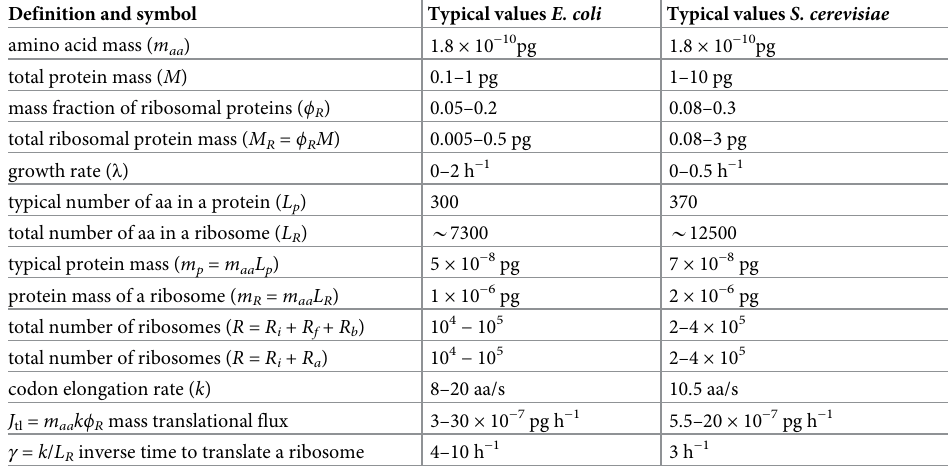
Table 1. Summary of the symbols used in the text. E. coli data are taken from [5, 25, 26]. S. cerevisiae data are taken from [4, 26, 27]. In the text we also use symbols for the number of free, active, inactive and transcript-bound ribosomes, which are R , R , R and R , f a i b